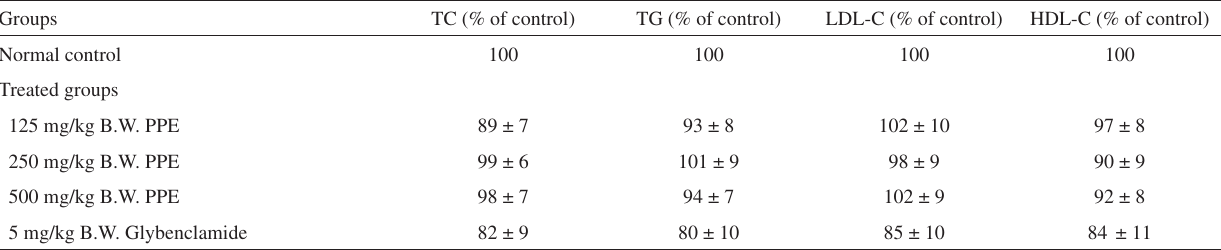
Table 2 - Comparison of serum lipid profiles in normal and PPE-treated normal rats. Groups